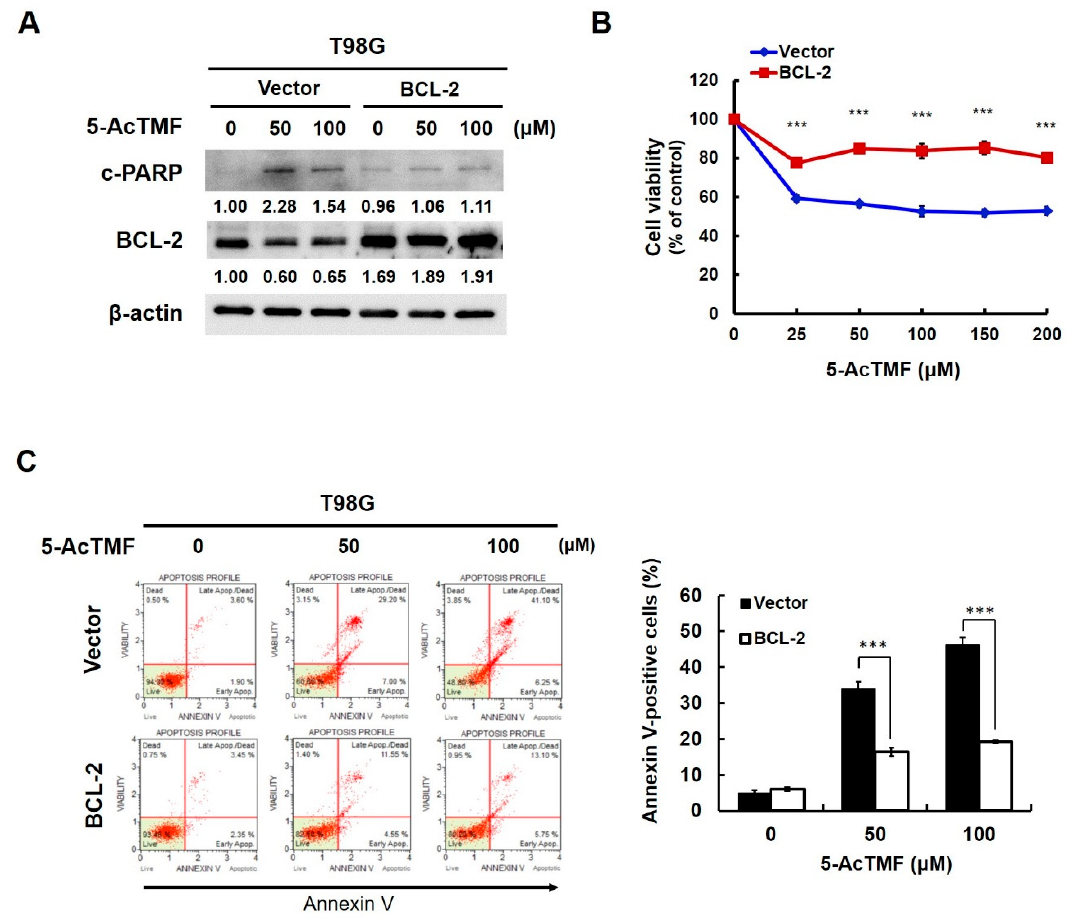
ff ect of 5-AcTMF on GBM